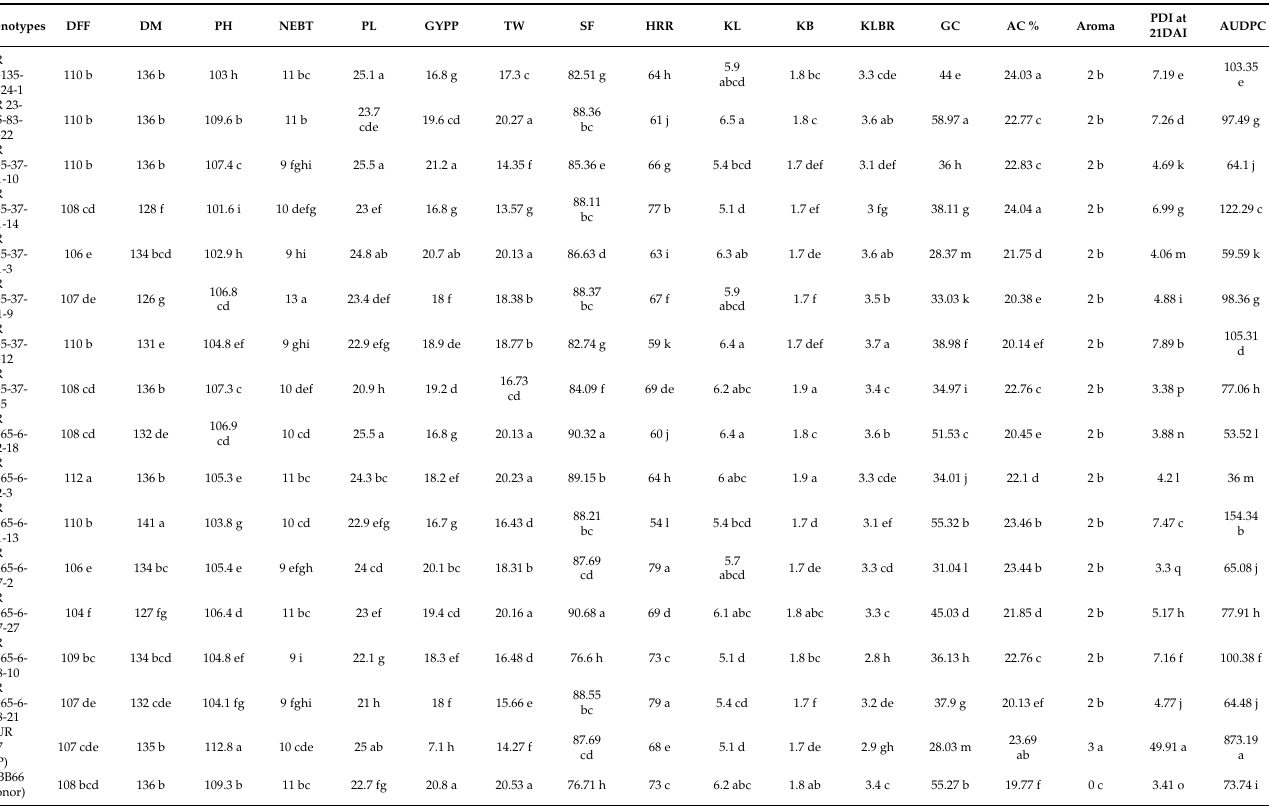
Table 6. Duncan’s Multiple Range test (DMRT) for analysis of pairwise differences among parents and NILs of HUR